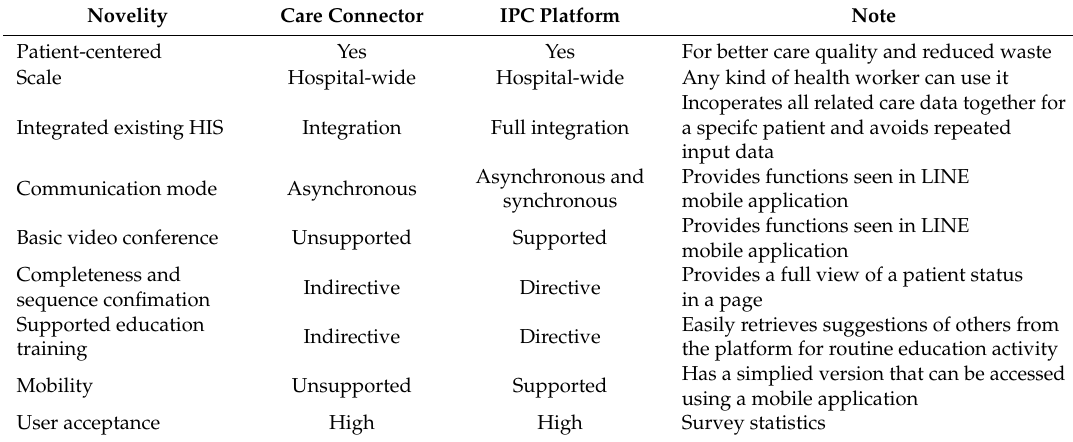
Table 5. A Comparison with Care Connector